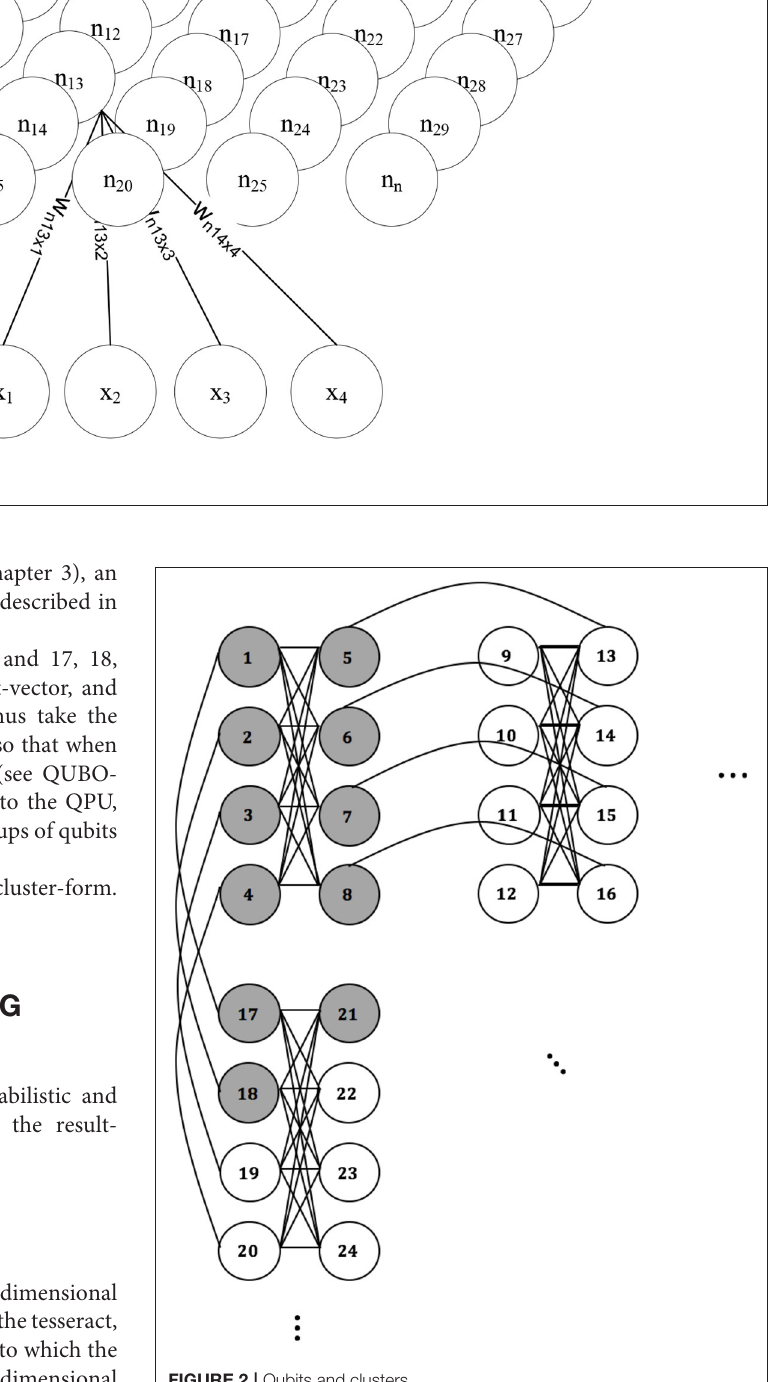
FIGURE 2 | Qubits and